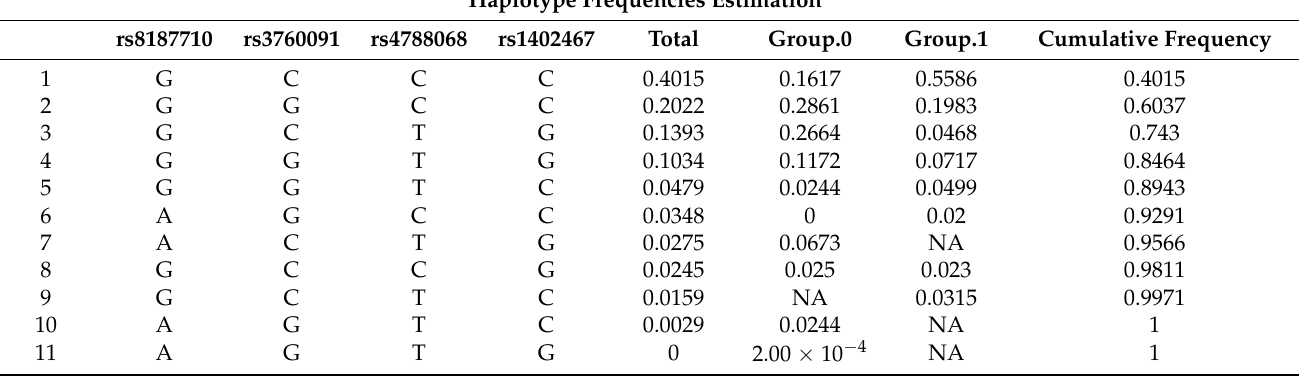
Haplotype Frequencies